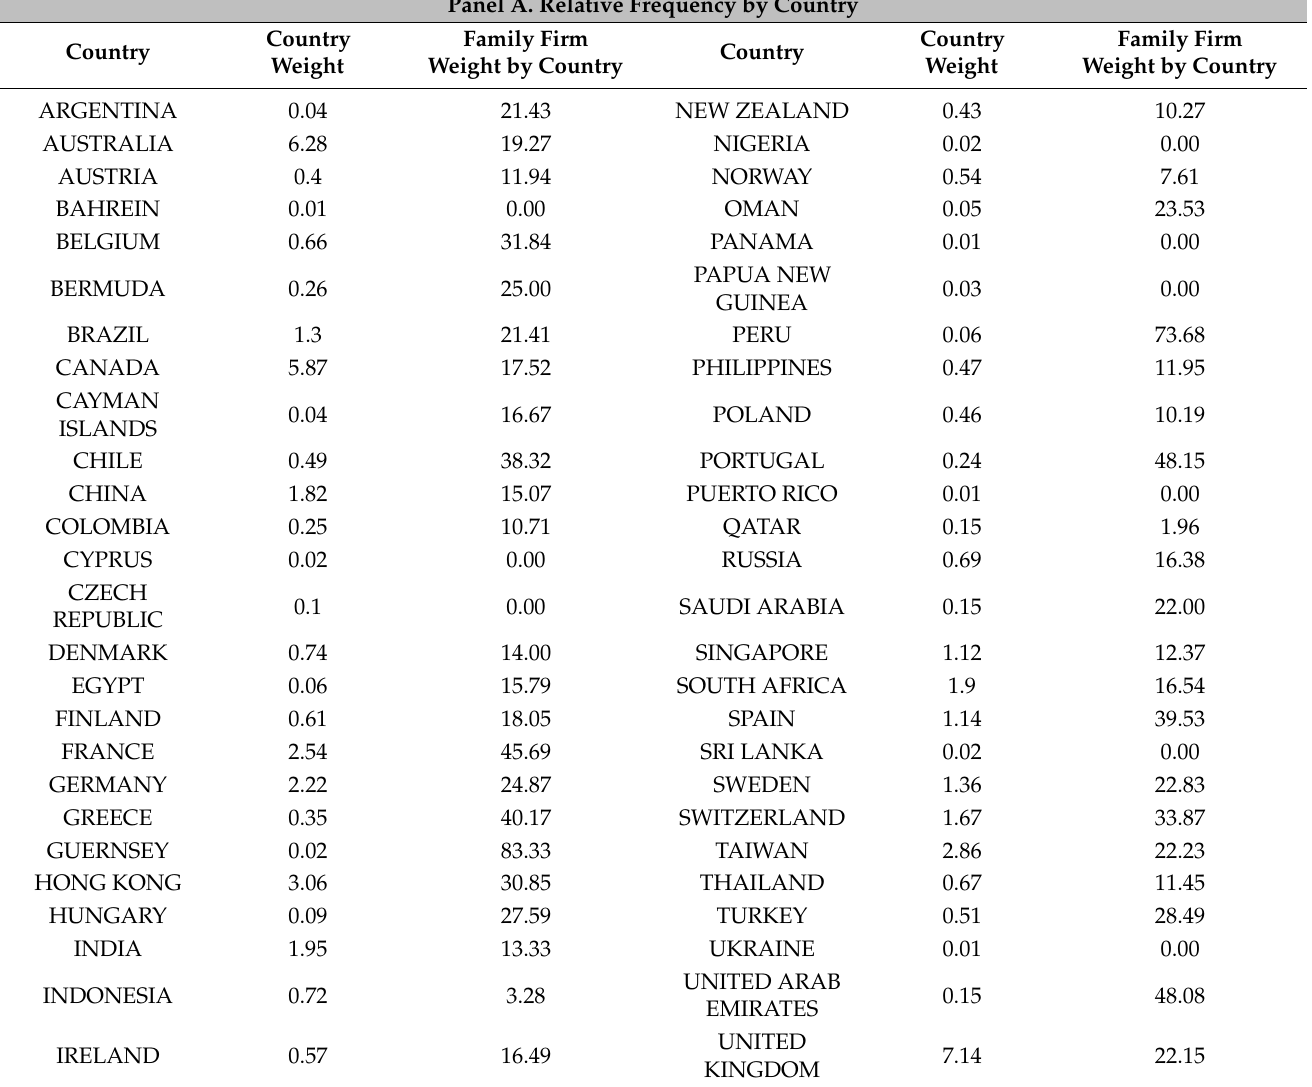
Table 1. Sample information. Panel A. Relative Frequency by